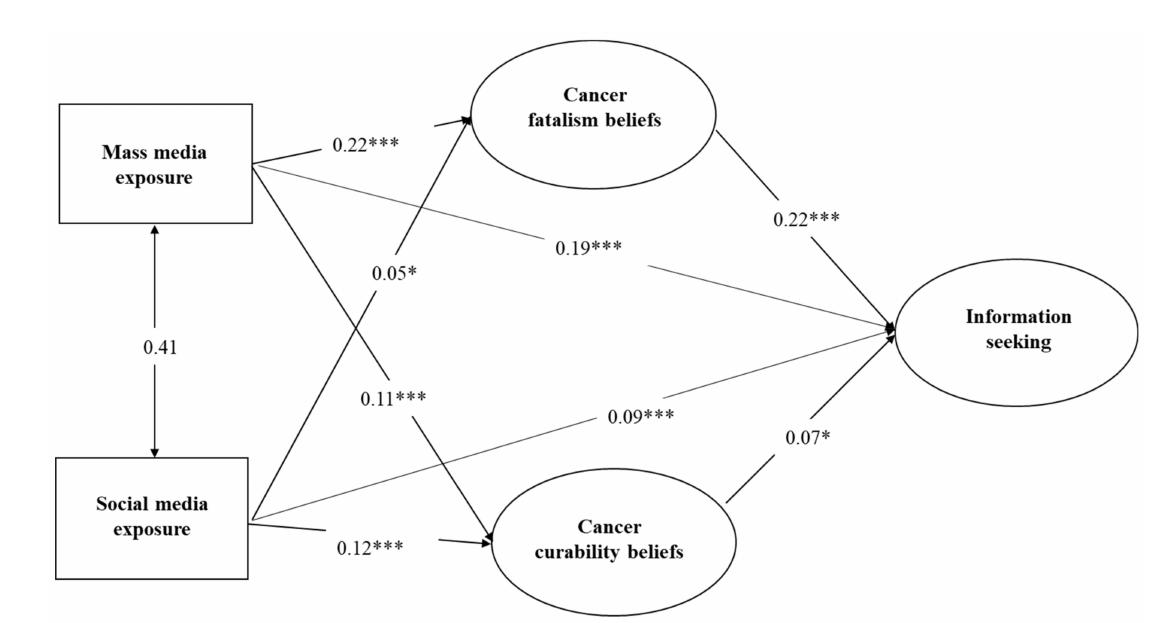
Figure 4. Path analysis of cancer information seeking (Model 2). Notes * p < 0.05, *** p <